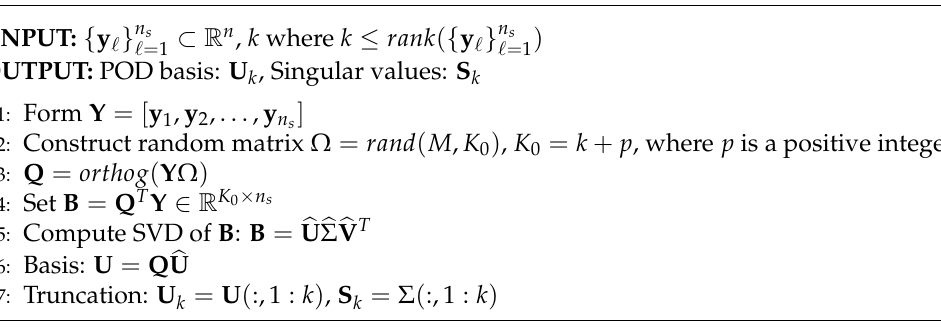
Algorithm 2 Randomized Singular Value Decomposition